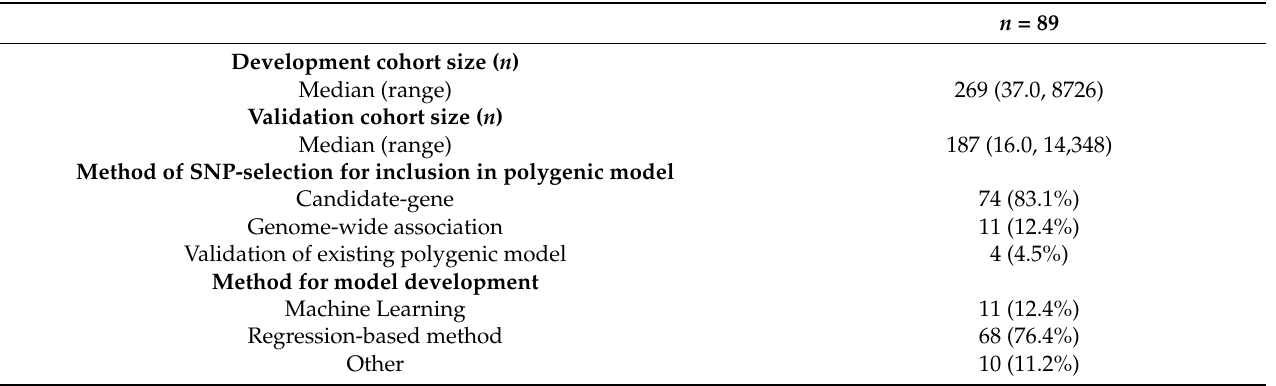
Table 1. Summary of sample and methods used for developing polygenic prediction models in pharmacogenomics